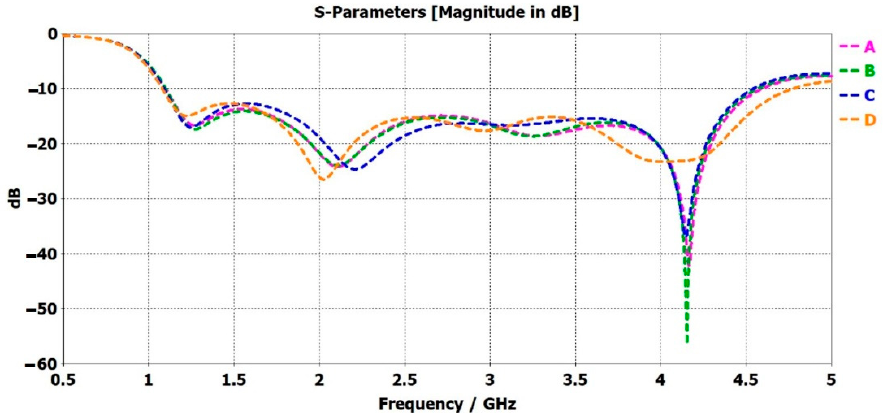
Figure 8. S-parameter (S 11 ) in the model for the unobtrusive sensor ( A ) on side of the table ( B ), on the wall to the right ( C ), above the bed, and ( D ) to the left of the bed.